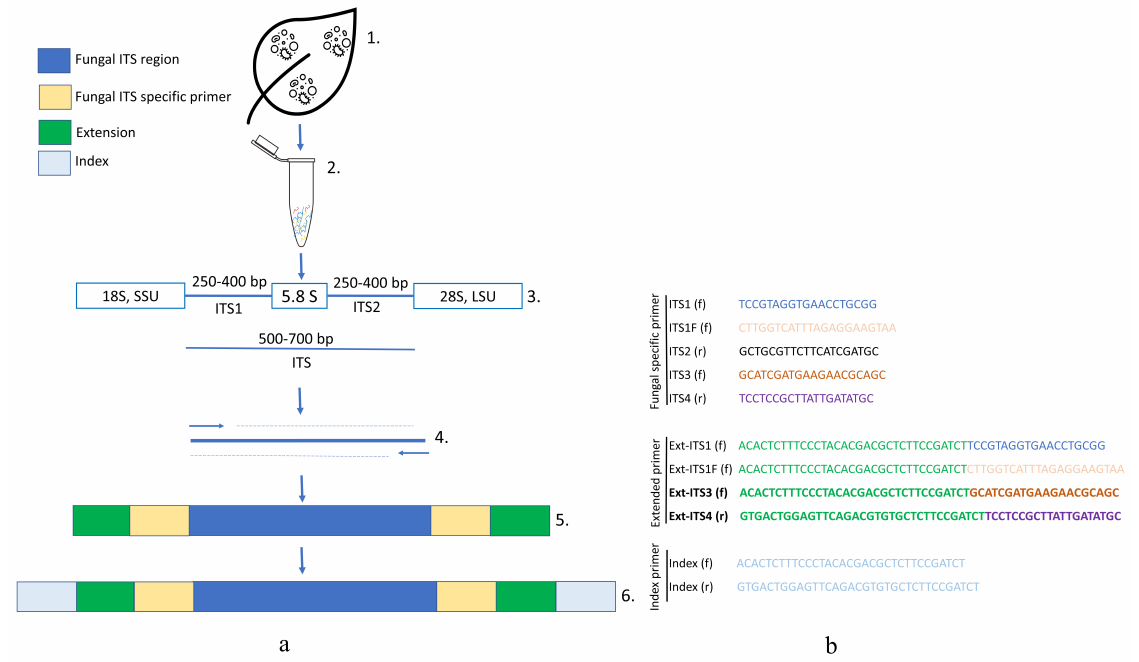
Figure 1. Workflow for preparing an amplicon library for high-throughput sequencing (HTS): ( a ) (1) leaves were harvested, lyophilized, and ground to powder; (2) DNA was extracted; (3) primers were designed to target the conserved fungal rDNA ITS region; (4) forward and reverse fungal- specific primers were generated for PCR; (5) extended PCR products were made, containing the ITS region (blue), the fungal-specific primer region (yellow), nucleotides as an overhang (green) and binding site for index primers; (6) addition of sample-specific index primers (pale blue) to the extension PCR product from (5), which were then compiled to create the amplicon library. ( b ) Primers tested in this study (selected primers used in